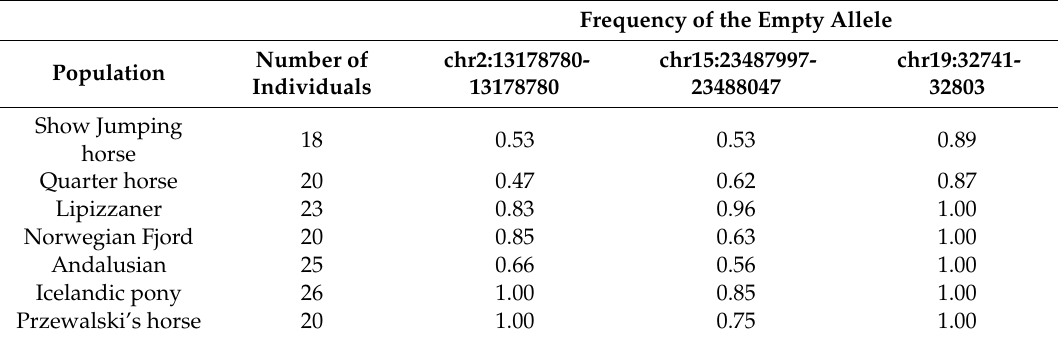
Table 2. Insertion polymorphism of ITS loci in seven horse